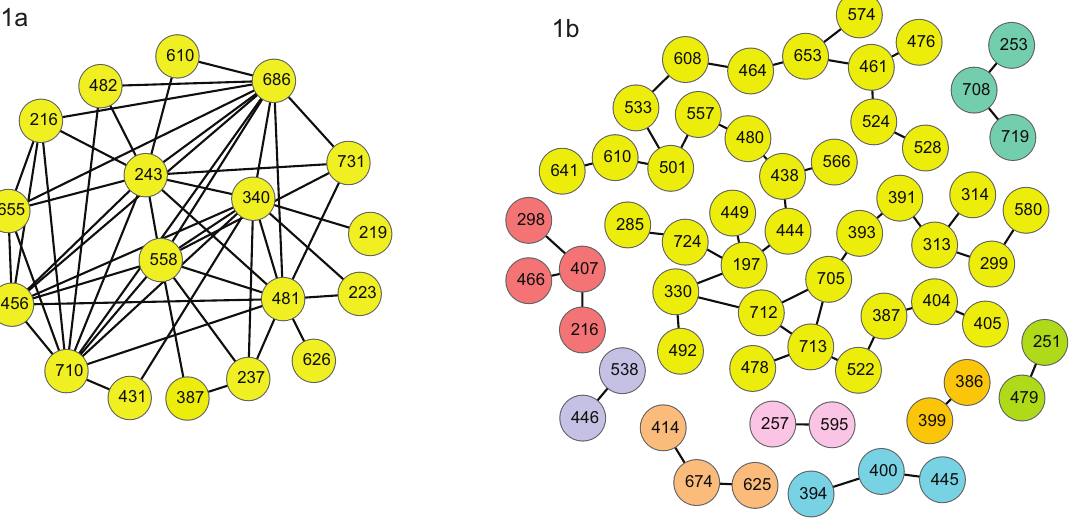
Figure 3. Networks of highest covarying pairs. The 50 aa pairs with the highest covariance values calculated over all individuals in genotypes a and b. Edges between nodes connect the covarying aa pairs.